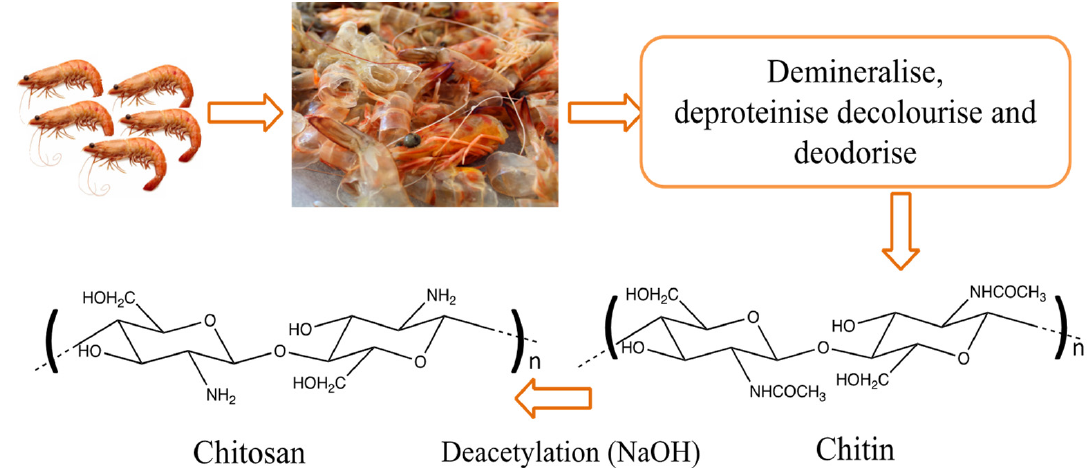
Figure 2. Process of obtaining chitosan by the deacetylation alkaline treatment of chitin from shrimp shell wastes.